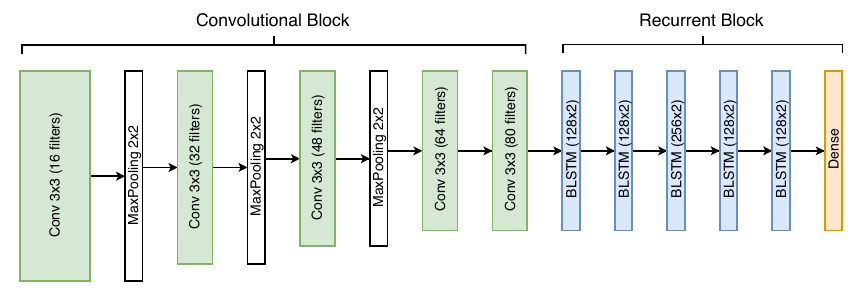
Figure 7. Puigcerver architecture